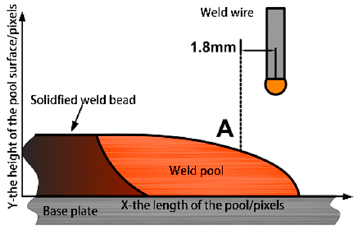
Figure 4. Position of the reference point: A.